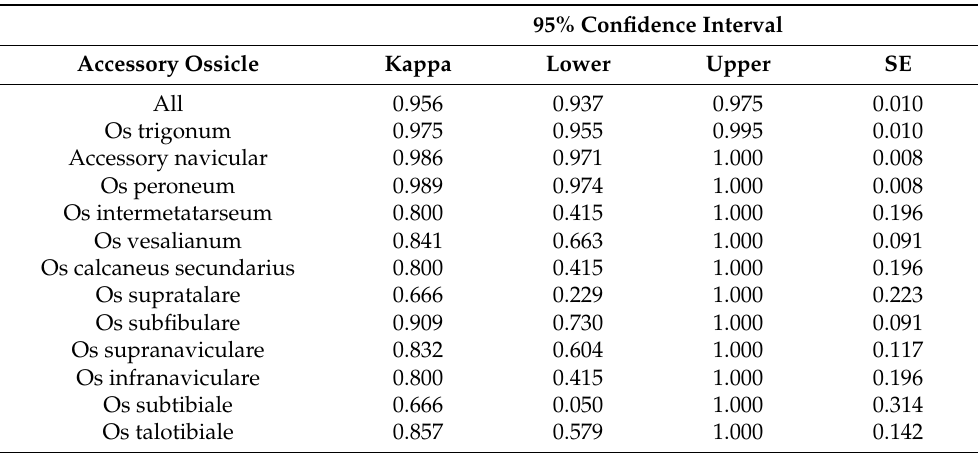
Table 2. Interobserver reliability (Kappa) for the detection of accessory ossicles.